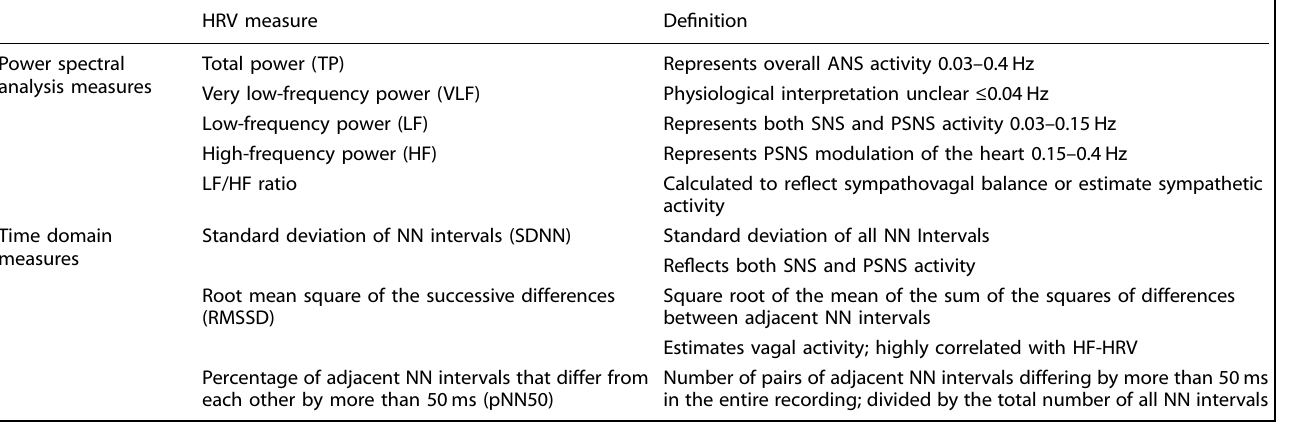
Table 2. Most common spectral and time-domain measures of HRV used in this